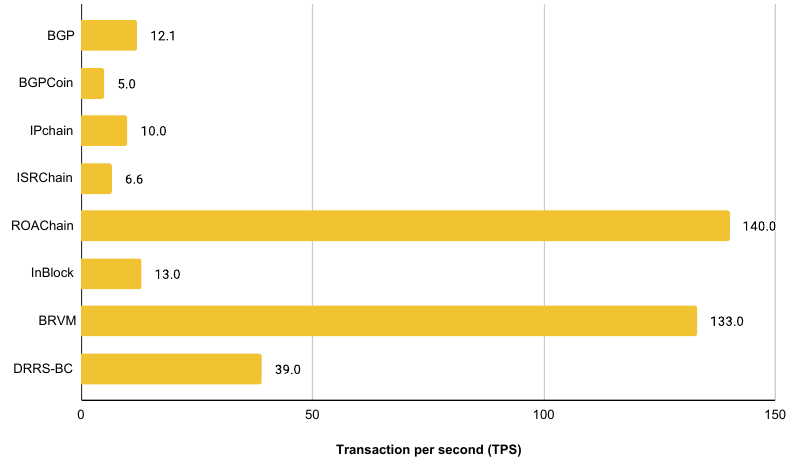
Figure 4. The comparison of TPS of the reviewed projects with